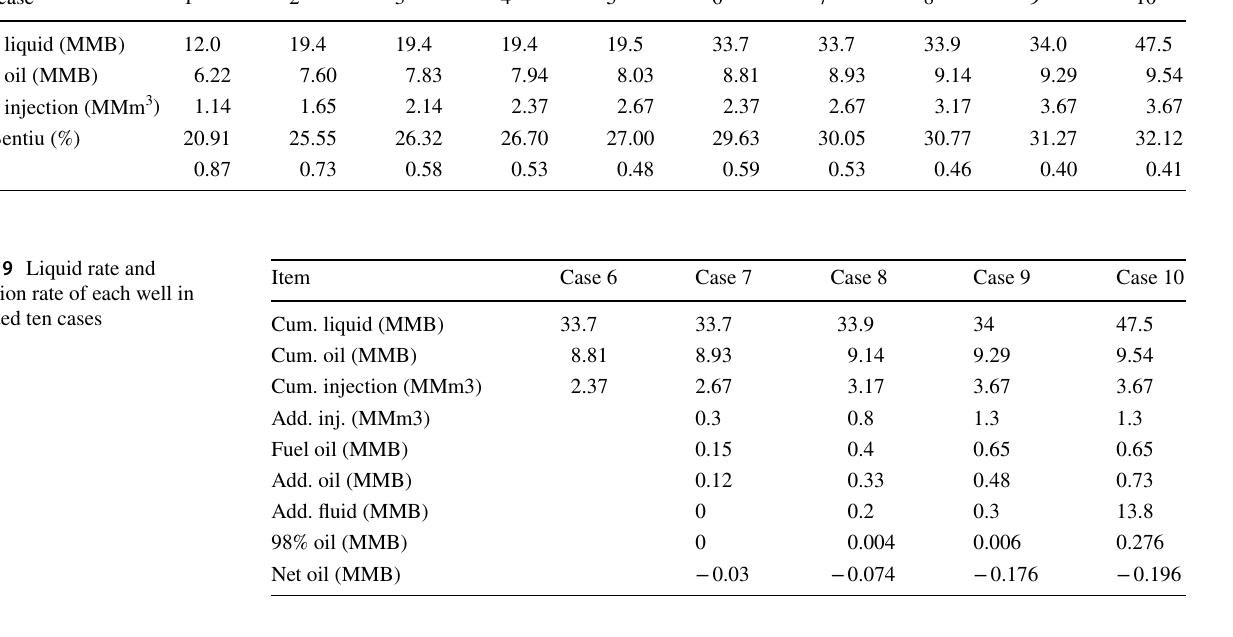
Table 8 Liquid rate and injection rate of each well in selected ten cases Item/case